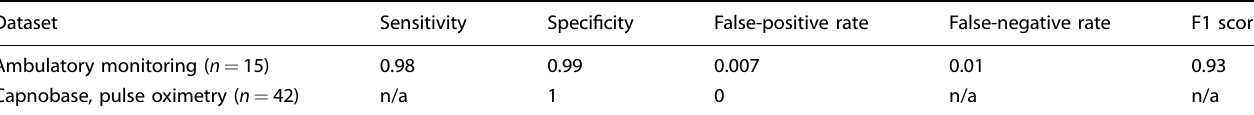
Table 3. External evaluation of DeepBeat.